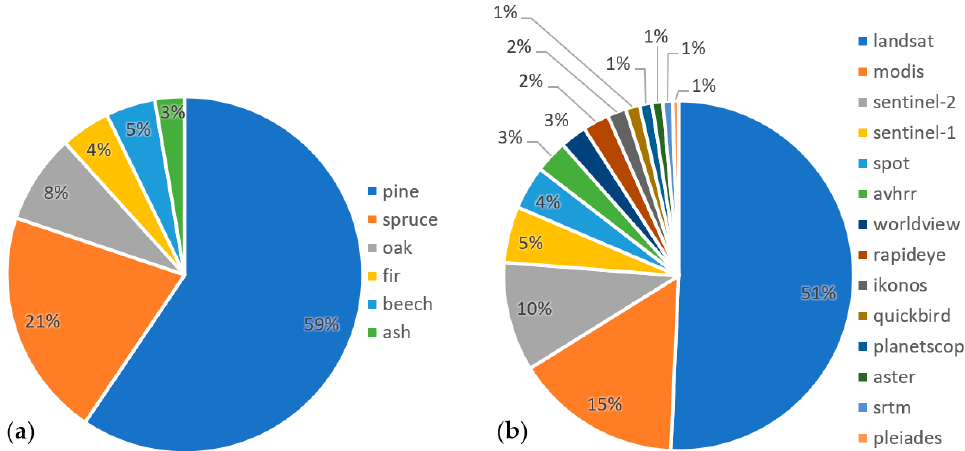
Figure 4. Published papers related to forest species dieback and remote sensing categorized by ( a ) dominant species and ( b ) relevant satellite mission.